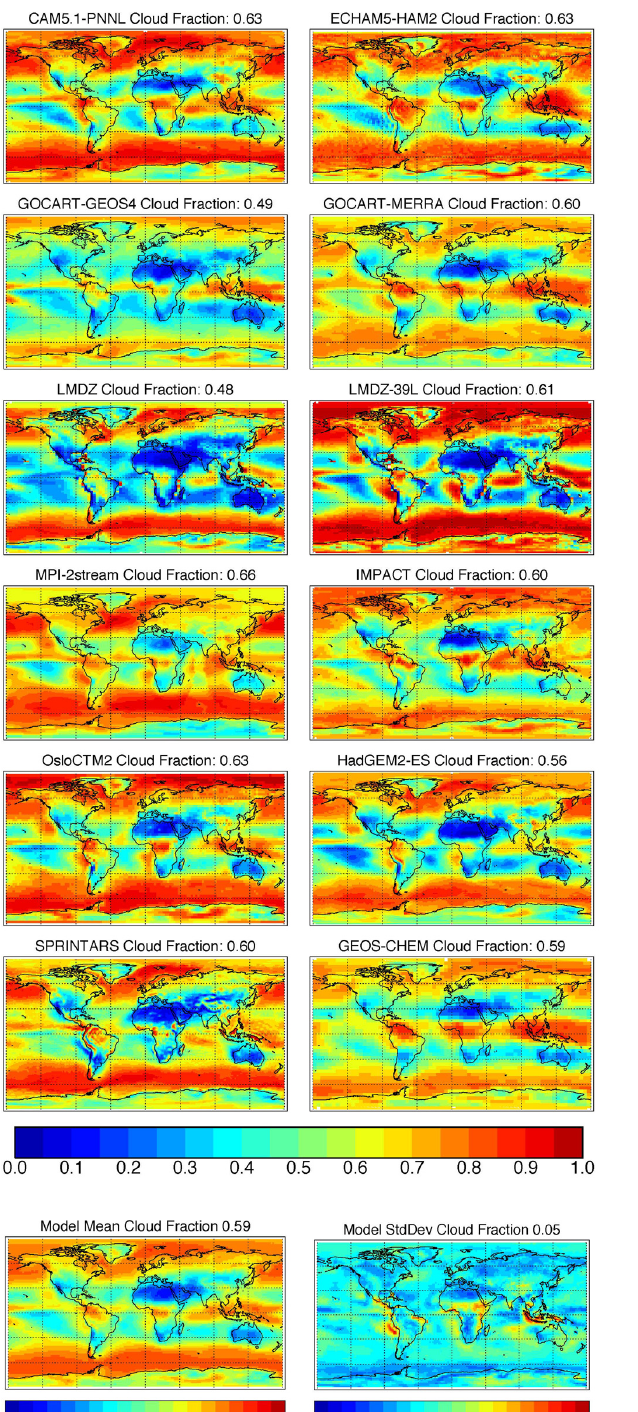
Fig. 2. Annual-mean cloud fractions for each of the models, annual multi-model mean and annual-mean multi-model standard devia- tion. Global annual means for each model and the mean and stan- dard deviation of the multi-model global annual-means are given in the respective titles.